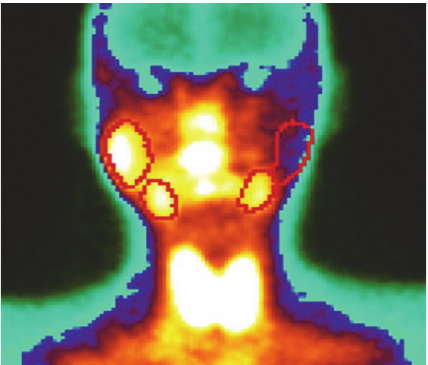
Figure 3: Technetium-99m pertechnetate scintiscan showing no activity in the left parotid gland and a normal activity in the other major salivary glands.